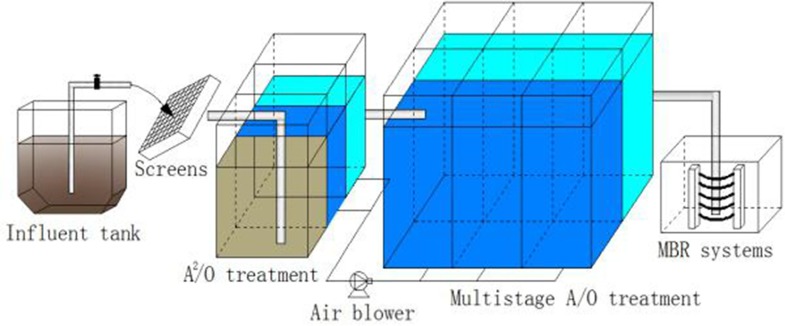
A schematic diagram.